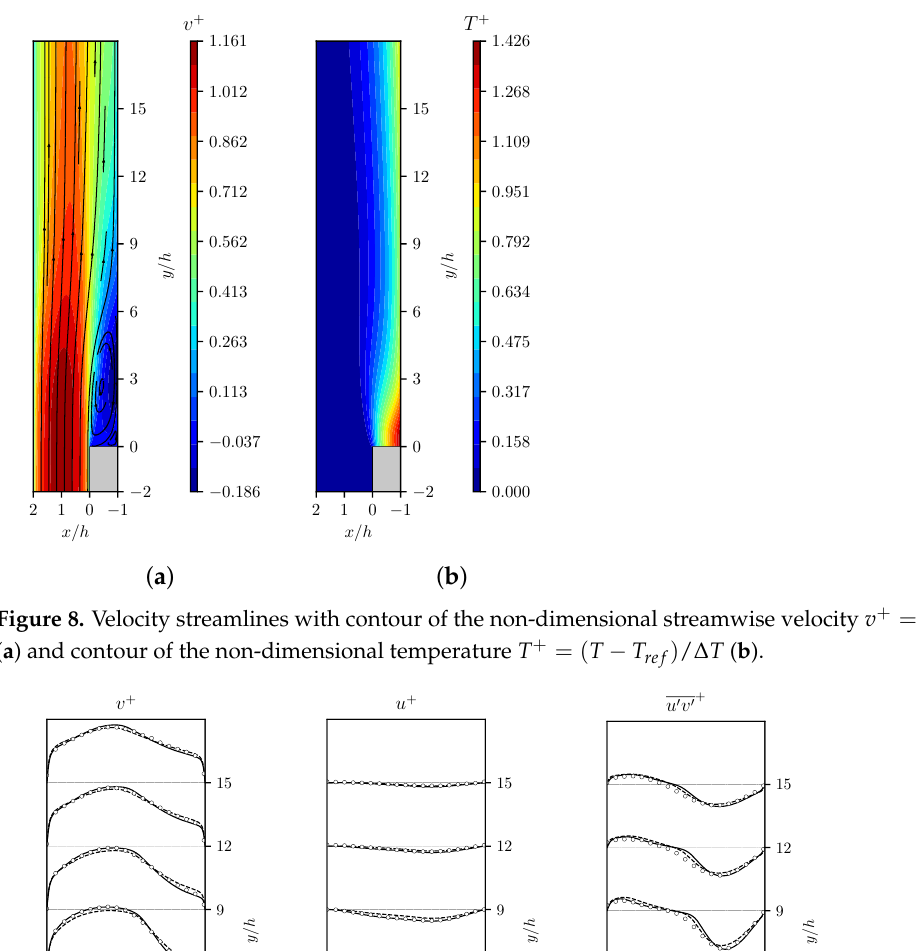
Figure 9. Profile of dynamical fields: Mean streamwise velocity v + ( a ), mean wall-normal velocity u + ( b ), and shear stress u (cid:48) v (cid:48) + ( c ). : Simulation results with the anisotropic four-parameter (A4P) model; : Simulation results with the isotropic four-parameter (4P) model. In Figure 9c, the non-dimensional shear stress component u (cid:48) v (cid:48) reference data for the anisotropic model results. For the isotropic four-parameter